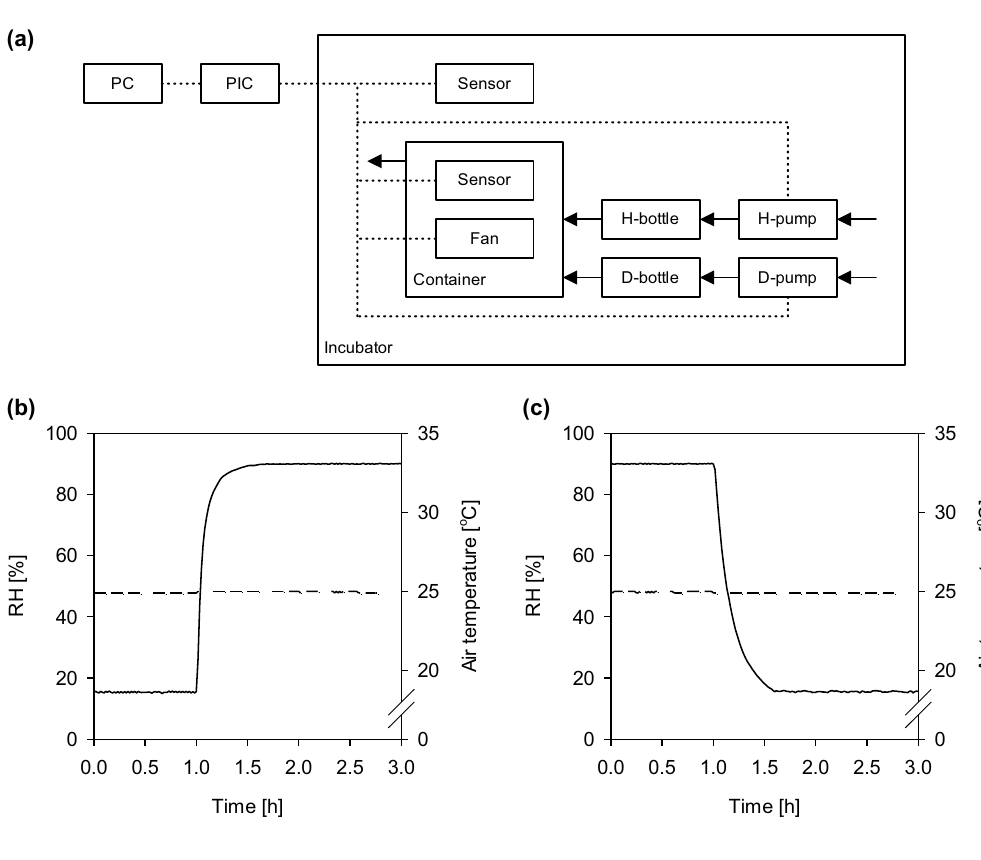
Figure 4. (a) A computer-based system for controlling humidity by combining streams of humidified and dehumidified air in an acrylic container. PC, netbook computer; PIC, peripheral interface controller; Sensor, relative humidity (RH) and air temperature sensor; H-bottle, bottle filled with water for humidifying air; D-bottle, bottle filled with silica gel for dehumidifying air; H-pump, pump for blowing air into the H-bottle; D-pump, pump for blowing air into the D-bottle. Broken lines represent electrical signals. Arrows indicate air flow. (b , c) Performance of humidification and dehumidification: time courses of RH (solid line) and air temperature (broken line) inside the container when air was (b) humidified from RH set-point of 15% to 90% or (c) dehumidified from RH set-point of 90% to 15% at 25 °C. Humidification and dehumidification were started 1 h after recording began. (Modified from